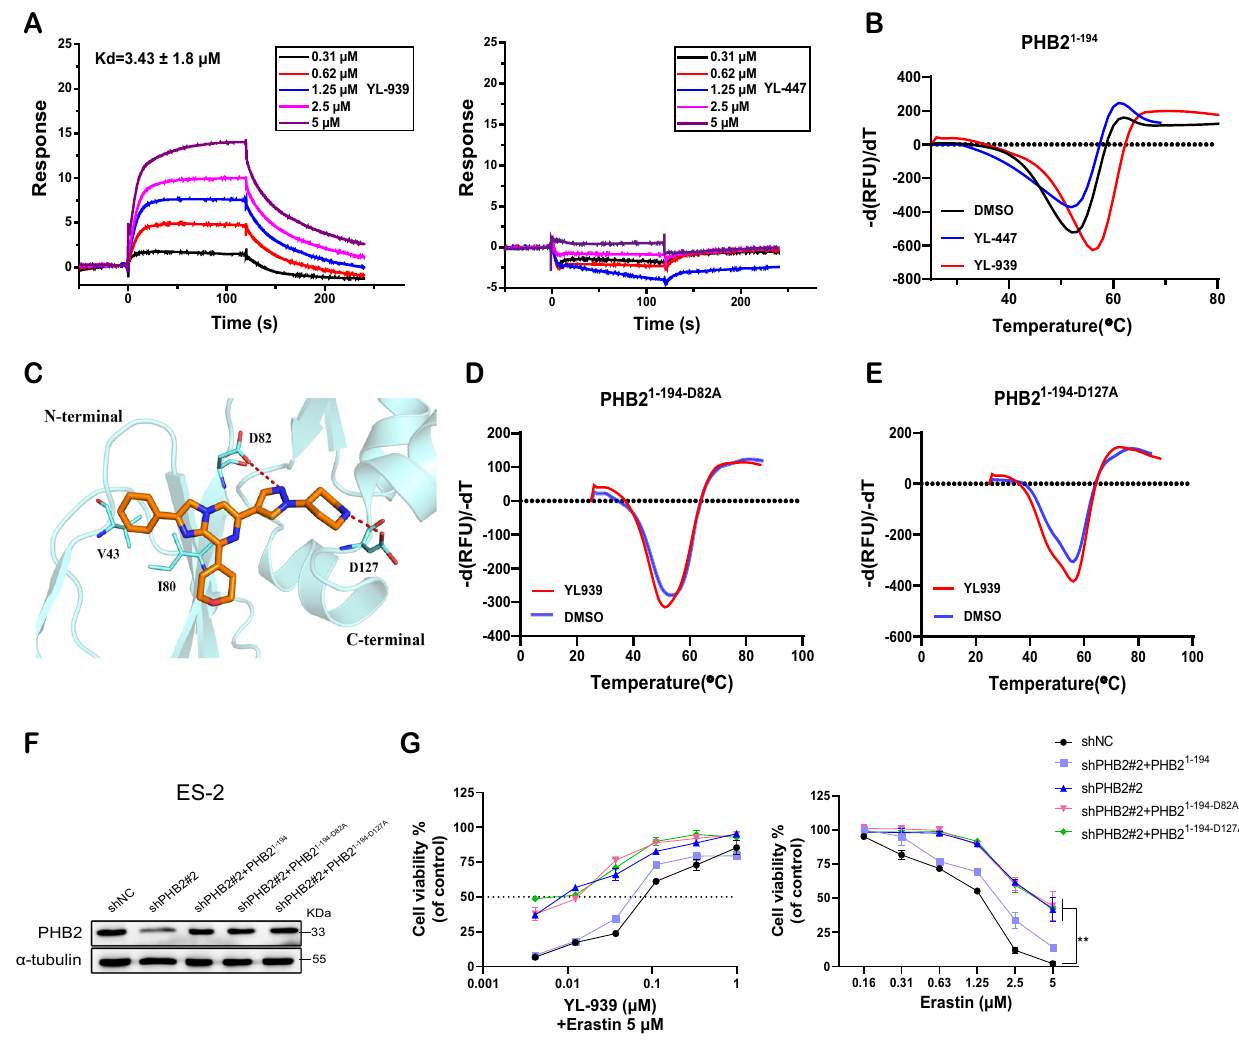
Fig.5|YL-939bindstothePHB2protein.A SPRanalysisofYL-939(left)orYL-447 (right)bindingtotherecombinantPHB2 1 – 194 protein.Datawereobtainedfromtwo biological replicates. B DSF analysis of YL-939 or YL-447 binding to the recombi- nant PHB2 1 – 194 protein. Data were obtained from three biological replicates. C A predicted bindingmodeofYL-939withPHB2 1 – 194 .Thethree-dimensionalstructure of PHB2 predicted by AlphaFold (https://alphafold.ebi.ac.uk/entry/Q99623) was used as the receptor structure. D DSF analysis of YL-939 binding to the recombi- nant mutated PHB2 1-194-D82A protein. Data were obtained from three biological